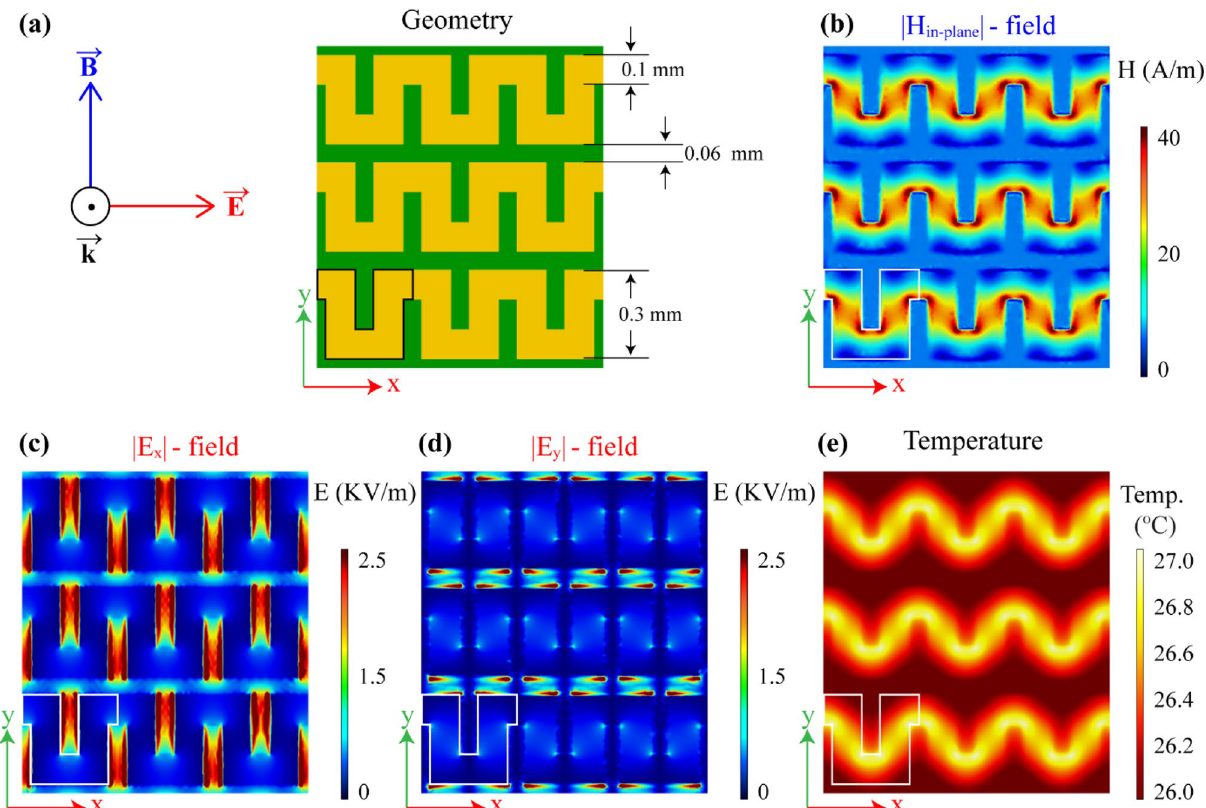
Figure 2. ( a ) Polarization direction of incident electromagnetic field and geometry of the metasurface structure. The simulation result of the indicator at 5 GHz for ( b ) in-plane magnetic field distribution (| H in-plane |), ( c ) x -component of electric field distribution (| E x |), and ( d ) y -component of electric field distribution (| E y |). ( e ) Thermal distribution on the metasurface under microwave radiation. Highlighted structures show the unit cell of the